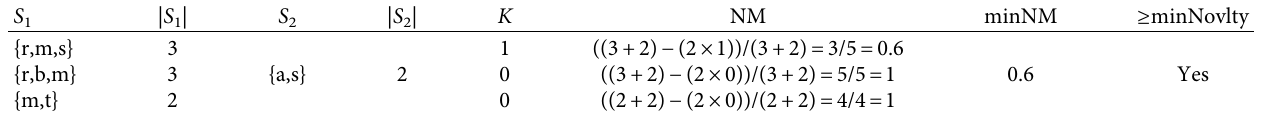
Table 3: NM calculation between the new MFIs {a,s} and all IMFIs in IMFI list.